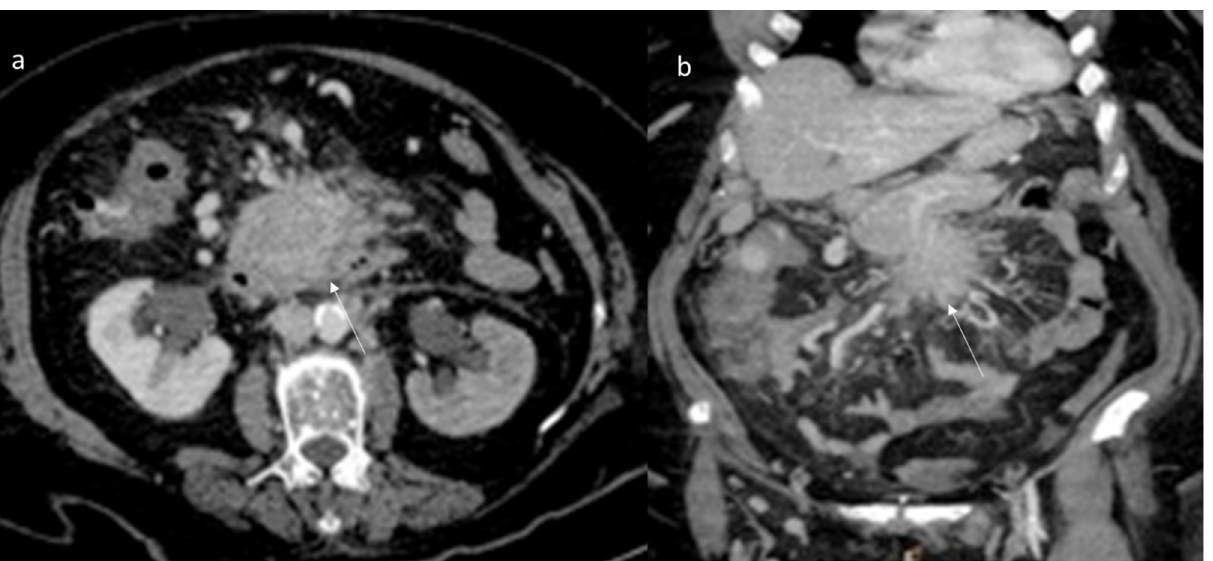
Figure 2. CT assessment (arrow) of mesenteric DT ( a ) in portal phase of contrast study. The lesion enhancement is mild to moderate. The 18-FDG ( b ) assessment (arrow) with moderate uptake. Sur- gical sample ( c ).